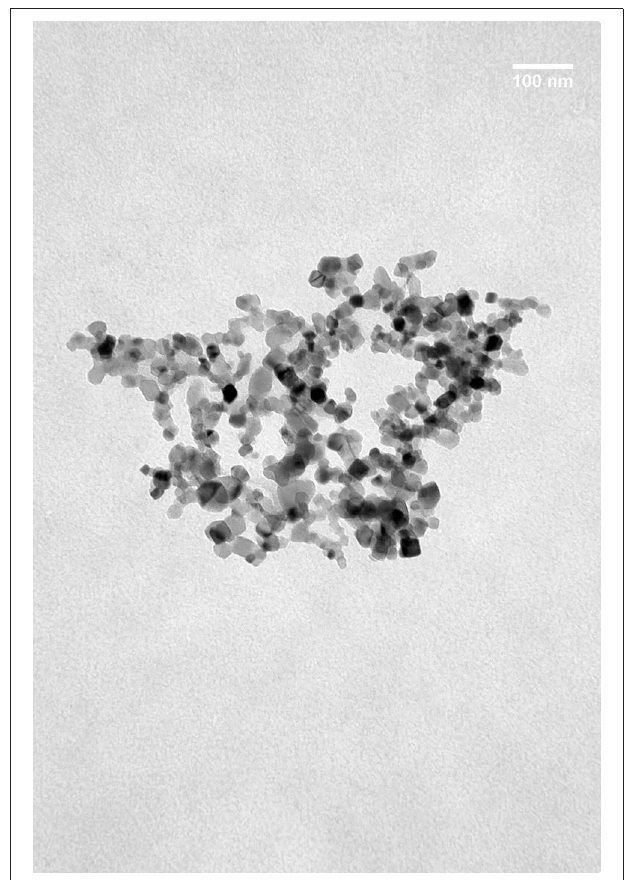
FIGURE 1 | TEM image of the TiO 2